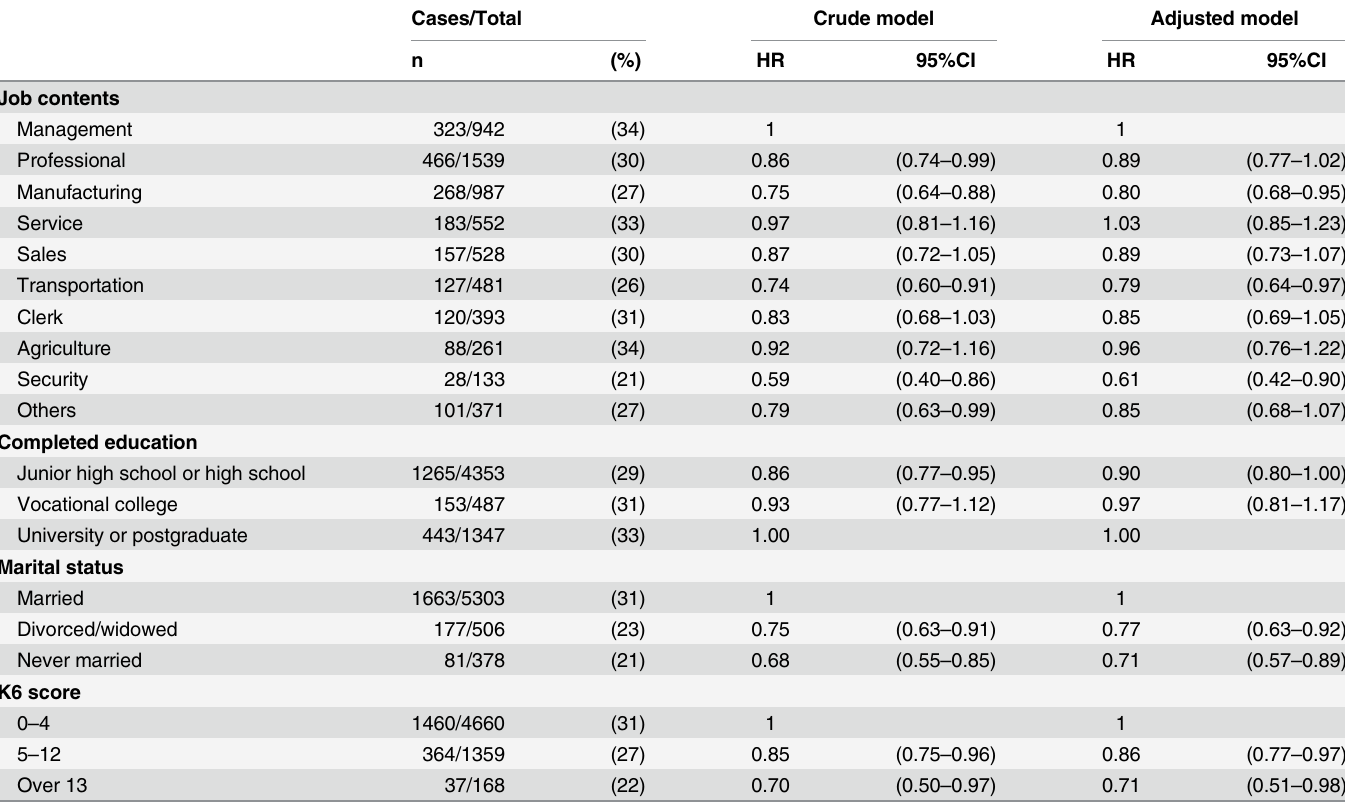
Table 2. Hazard ratios for quitting smoking and their association with socioeconomic status (n =